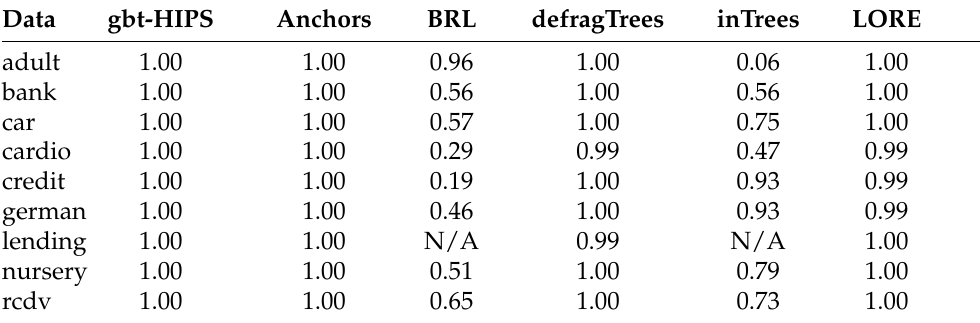
Figure 8. Distribution of rule cardinality for stochastic GBT model explanations. Table 7. Rule length floor (threshold 0) for the stochastic GBT model. This statistic shows the proportion of explanations with antecedent length >